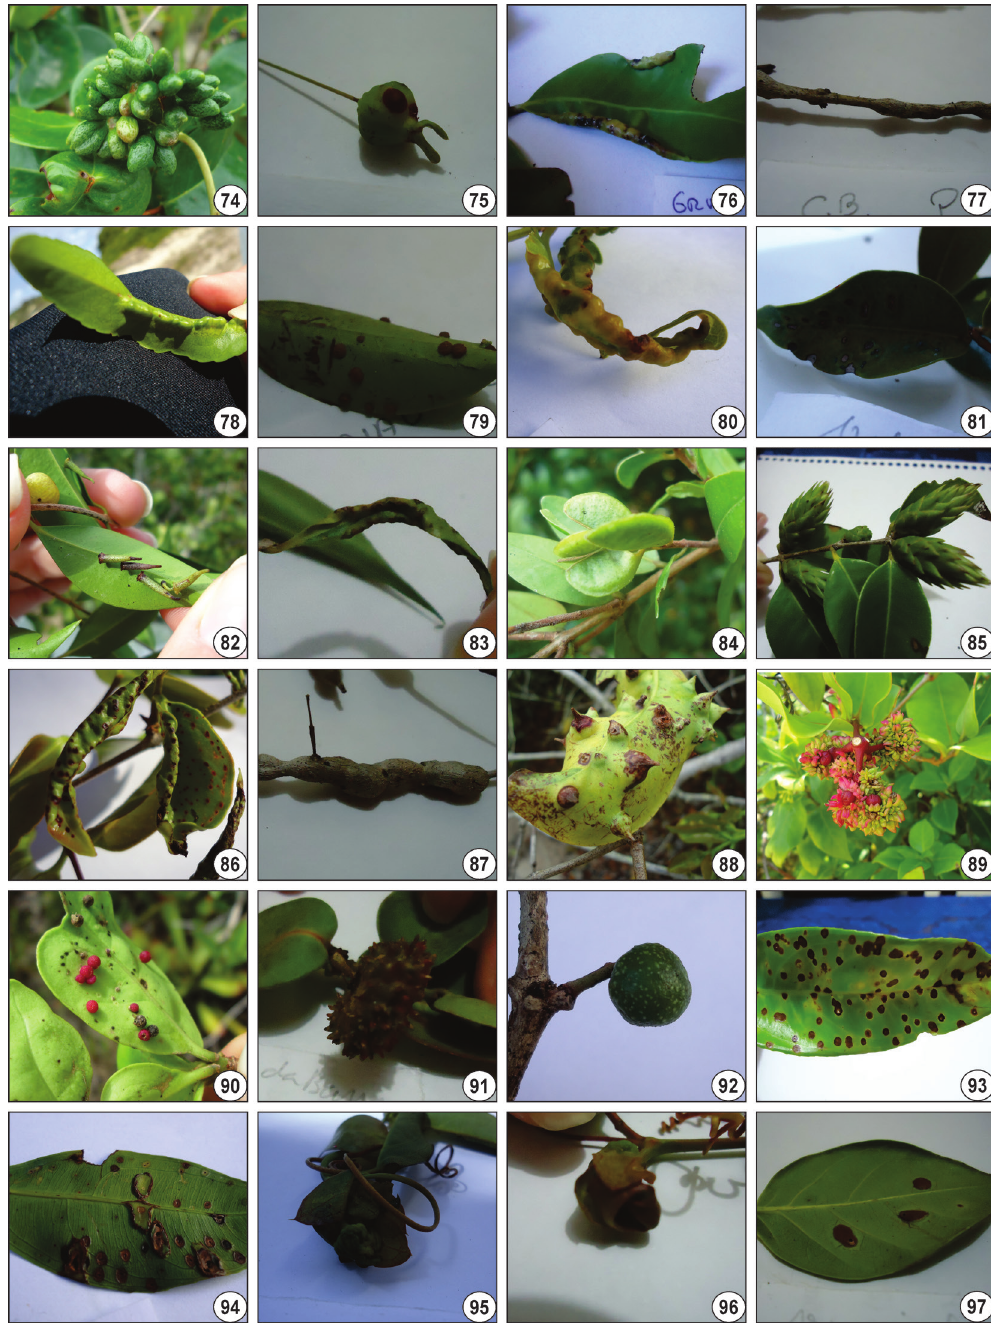
Figs. 74-97 - Galling insects from Parque Estadual da Costa do Sol and RPPN Fazenda Caruara (RJ, Brazil). 74-75, Eugenia uniflora , 74, conical leaf gall, 75, fruit gall. 76-77, Eugenia sp., 76, marginal roll, 77, stem gall. 78-81, Myrcia ovata , 78, conical leaf gall, 79, globoid leaf gall, 80, marginal roll, 81, lenticular leaf gall. 82-83, Myrciaria floribunda , 82, cylindrical leaf gall, 83, marginal roll. 84, Myrciaria tenella , young leaf fold. 85-87, Neomitranthes obscura , 85, pine-like gall, 86, leaf fold, 87, stem gall. 88, Psidium cattleianum , conical leaf gall. 89-92, Guapira opposita , 89, rosette gall, 90, globoid leaf gall, 91-92, bud gall. 93, Ouratea cuspidata , lenticular leaf gall. 94, Ouratea sp., lenticular leaf gall. 95, Passiflora alliaceae , bud gall. 96, Passiflora mucronata , leaf fold gall. 97, Coccoloba rigida , lenticular leaf